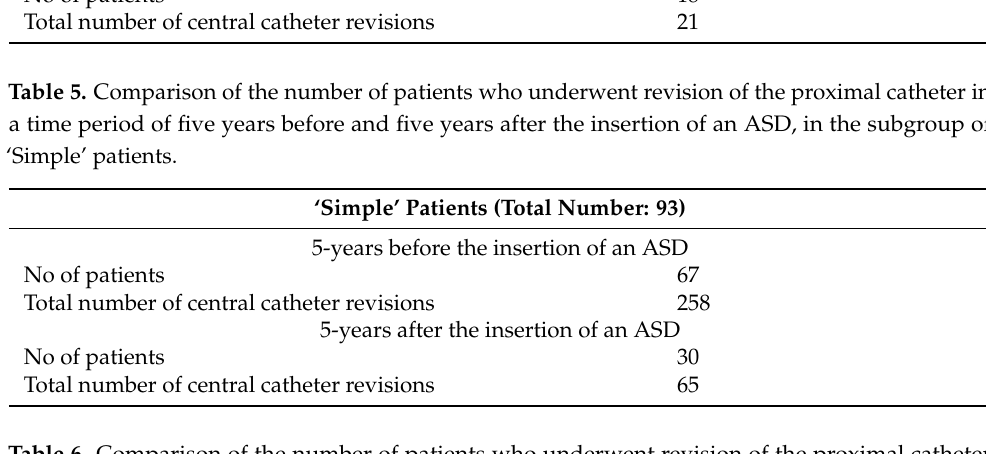
Table 6. Comparison of the number of patients who underwent revision of the proximal catheter in a time period of one year before and one year after the insertion of an ASD, in the subgroup of ‘Complex’ patients.